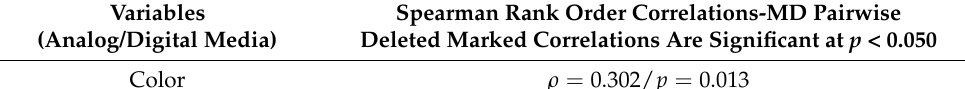
Table 2. Spearman’s correlation coefficient on analog and digital media.